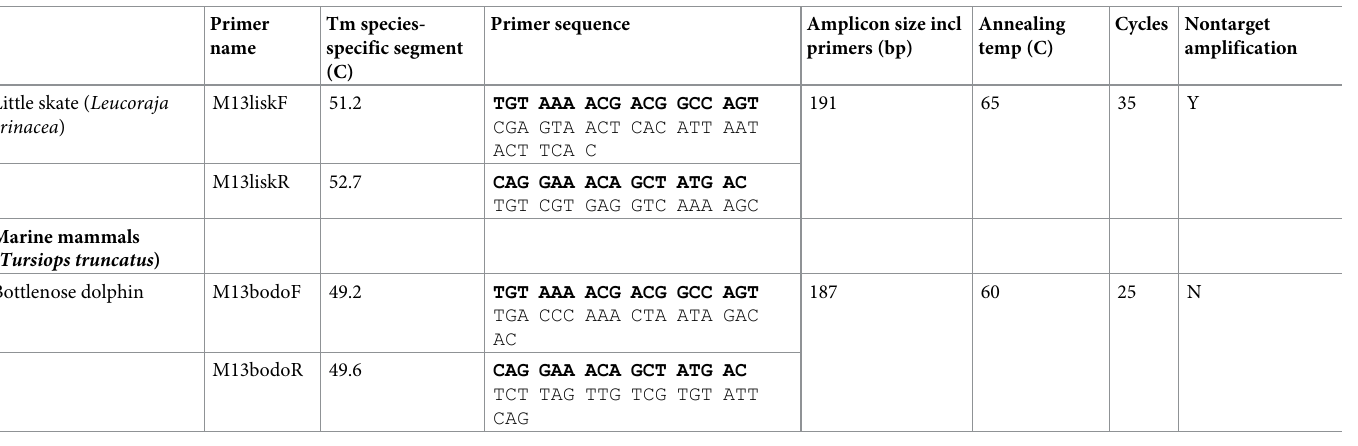
modified to favor cartilaginous fish or mammals (Table 1). Species-specific GoFish amplifica- tions successfully detected three shark species, four rays, and two skates (Table 2). In a nine- month time series of water samples from southern New Jersey, most (64%) cartilaginous fish positives were in summer months (p = 0.017 spring vs. summer; p = 0.001 summer vs. fall, Fisher’s exact test), consistent with seasonal migration patterns (Fig 4) [59]. This statistical analysis excluded little skate ( Leucoraja erinacea ), a cold water species [60] which was detected in spring and fall samples but not in summer. Sanger sequencing confirmed species ID for all gel-positive amplifications, except that clearnose skate ( Raja englanteria ) and little skate prim- ers amplified non-target sequences in some samples. A GoFish assay for bottlenose dolphin ( Tursiops truncatus ) was positive in most summer and fall samples; sequencing verified all (Table 2, Fig 4).